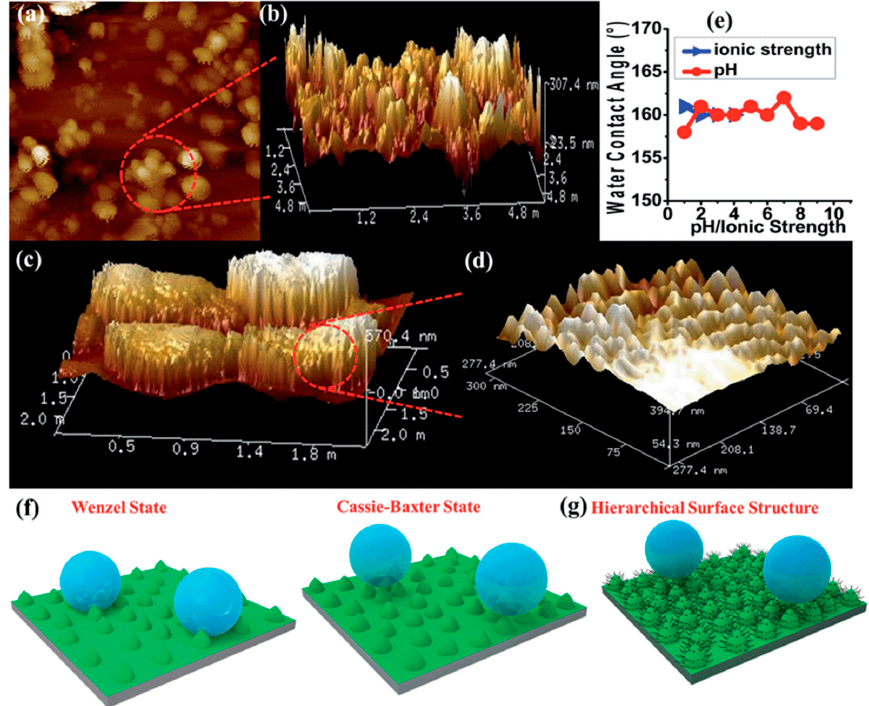
Figure 10. ( a ) 2D-AFM image of NMOF-1 micro-particles on coated glass surface; ( b ) Corresponding 3D-AFM; ( c ) 3D-AFM image of four adjacent microspheres of NMOF-1; ( d ) Corresponding high magnified image showing continuous nano-roughness present on each micro-particle ( e ) Plots showing changes in CA with pH/ionic strength; ( f ) Schematic showing the different states use to explain